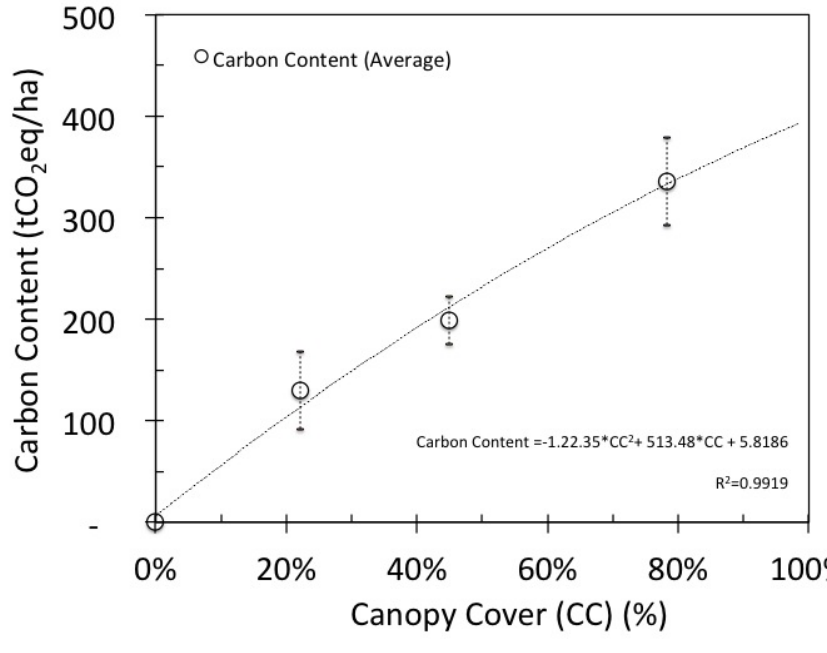
(CI) b Percentage Uncertainty (U) (%); this it half the 95% confidence interval divided by the mean. Figure 3. Relationship between canopy cover (CC) and carbon content for Low (<30%), Medium (30%–60%) and High CC (>60%) in oak-pine mixed forest in La Primavera, México (mean values and 95% confidence